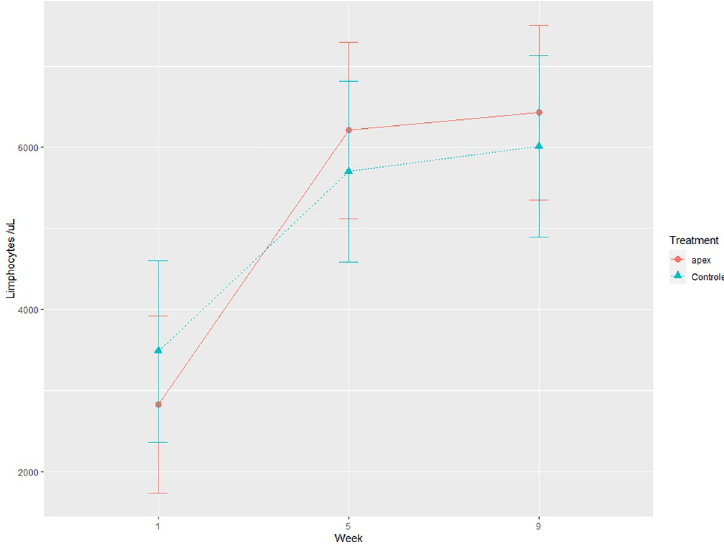
Fig 2. Lymphocytes values of control heifers (CON) and heifers supplemented with 1.0 g/calf/ d of a blend of essential oils (BEO) in milk replacer during the pre-weaning period.